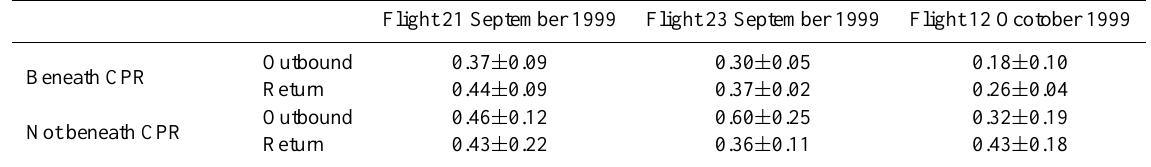
Table 3. Mean ozone miximg ratios (ppmv) below the 415K isentrope, but above the tropopause, measured by the APE-GAIA mission in September and October 1999. Standard deviations are reported along with the means. “CPR” stands for chemically perturbed